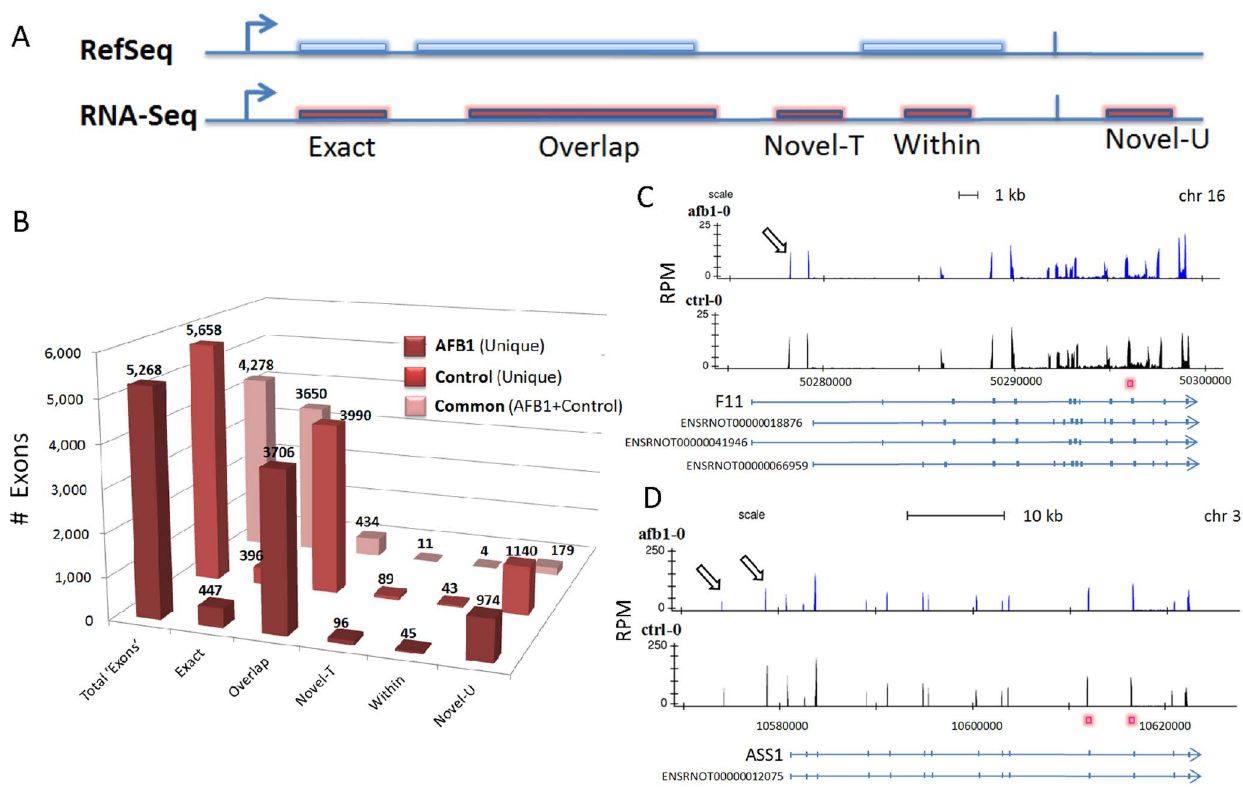
Figure 5. Novel exons found by RNA-Seq analysis. Panel A shows classification of different types of exons encountered during analysis of a Cufflinks assembled transcript in a model gene. Exons include ‘Exact’ matches to known exons, ‘Overlapping’ exons corresponding to partial matches, ‘Novel-T’ exons that occur with known transcripts, ‘Within’ exons occurring within the sequence of known exons and Novel-U exons that were unknown and occur outside known transcripts. Panel B is a bar chart of such exon types that were unique to AFB1 or Control treatments and those exons that were shared between treatments. Examples are shown for a Novel-T exon (Panel C) within the F11 transcript and two Novel-U exons (Panel D) outside the ASS1 gene. Numbers of reads, as RPM, are shown on the Y-axis and the genomic region is displayed on the X-axis for representative AFB1 (blue reads) and CTRL (black reads) sample tracks in UCSC browser format.